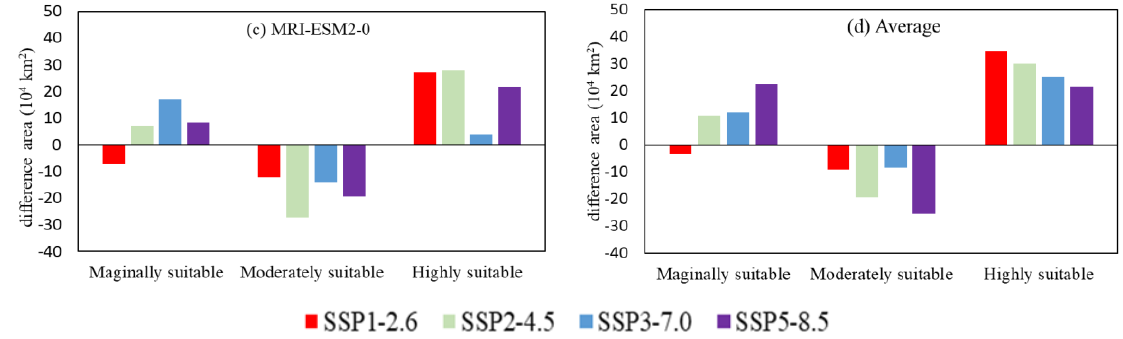
Figure 8. Differences between future and current (future − current) suitable area.